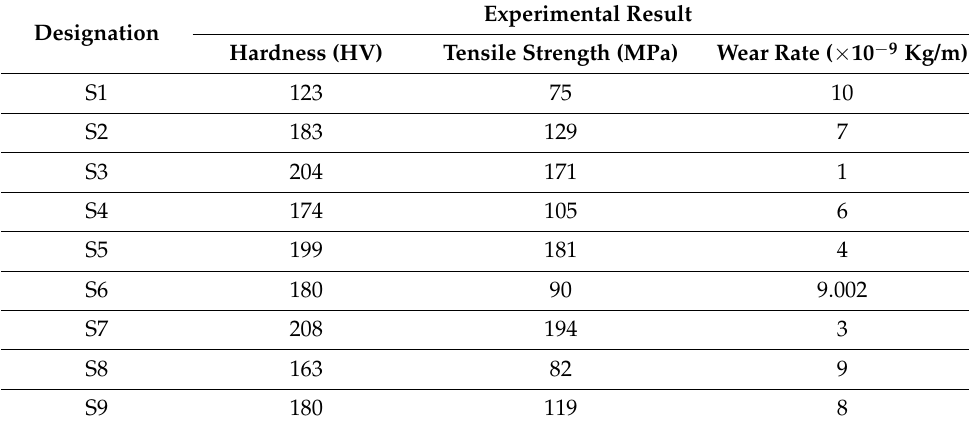
Table 6. Experimental results of hardness, tensile strength, and wear rate